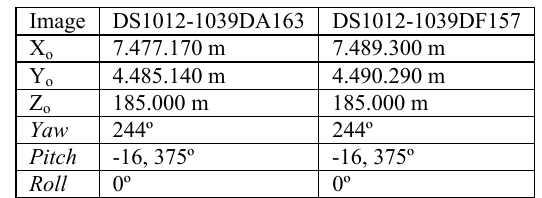
Table 2. Table of the initial exterior orientation parameters of the images.